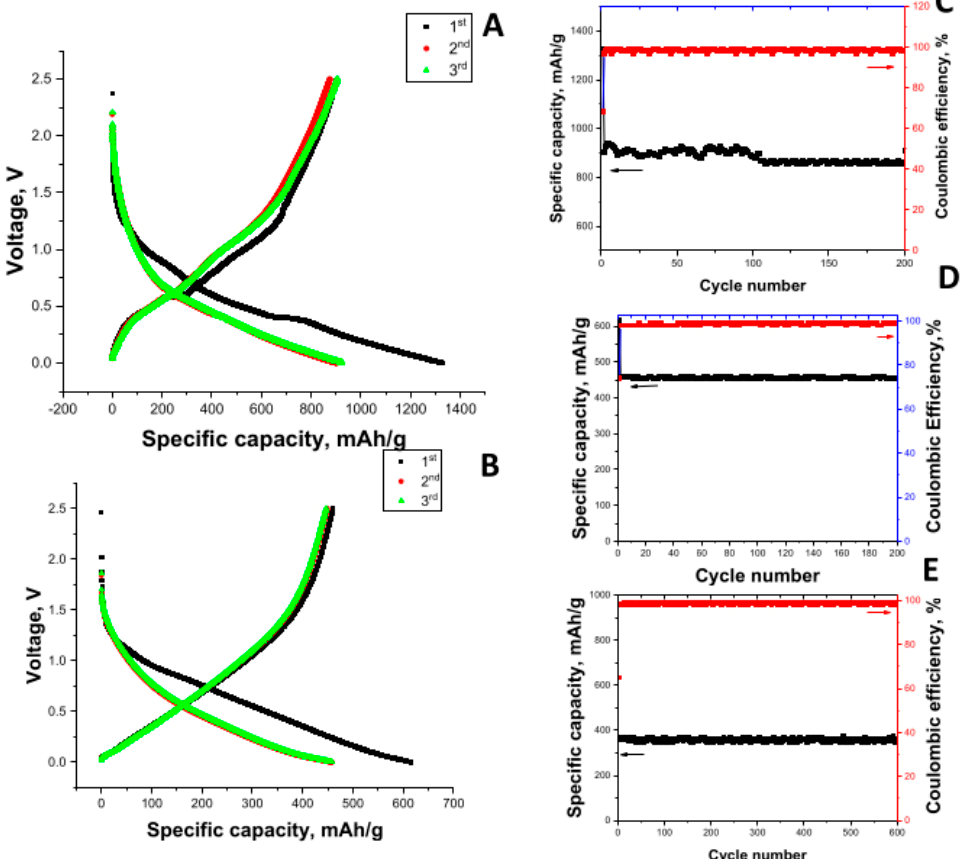
Figure 7. First-cycle discharge/charge curves and cycling performance of MoS 2 -decorated graphene@porous carbon nanofiber electrodes in Li-ion ( A , C ) and Na-ion batteries ( B – E ).